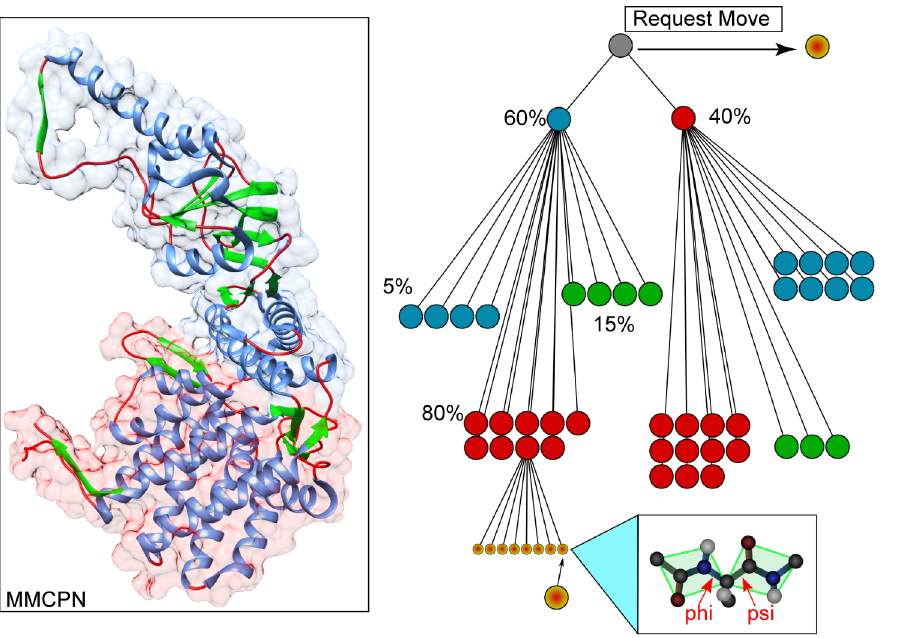
Figure 1. Example of a structured schema for an arbitrary molecule. Subsets of DOF s are defined, along with the associated weighting (shown here as percentages) defining the relative probability of selection. Though this example is non-overlapping and hierarchical, any combination of possibly non-contiguous subsets are allowed in our implementation. In this example, a move is generically requested, and subsequently sampled probabilistically from the set containing all loop regions in the top (blue) region of the structure. The yellow circles represent possible moves.